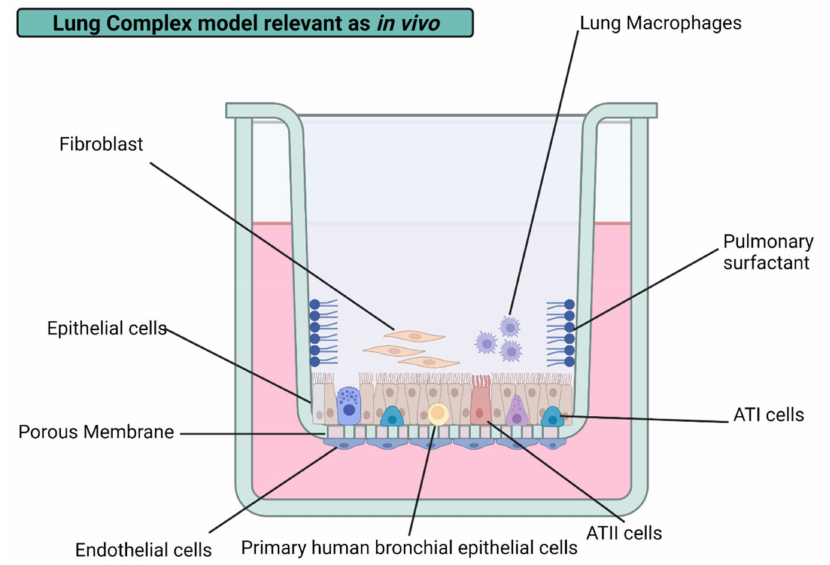
Figure 4. The image shows a proposal for a 3D model and the components that should be incorporated to generate better predictor models of the respiratory toxicity of AgNPs in vitro in future lung toxicology research. The addition of primary bronchial, epithelial, endothelial, fibroblast, ATI, and ATII cells will allow the in vitro representation of the physical barriers of the lungs. In turn, the addition of components such as pulmonary surfactant and macro-phages will allow the correct simulation of the cellular microenvironment and the immune defense